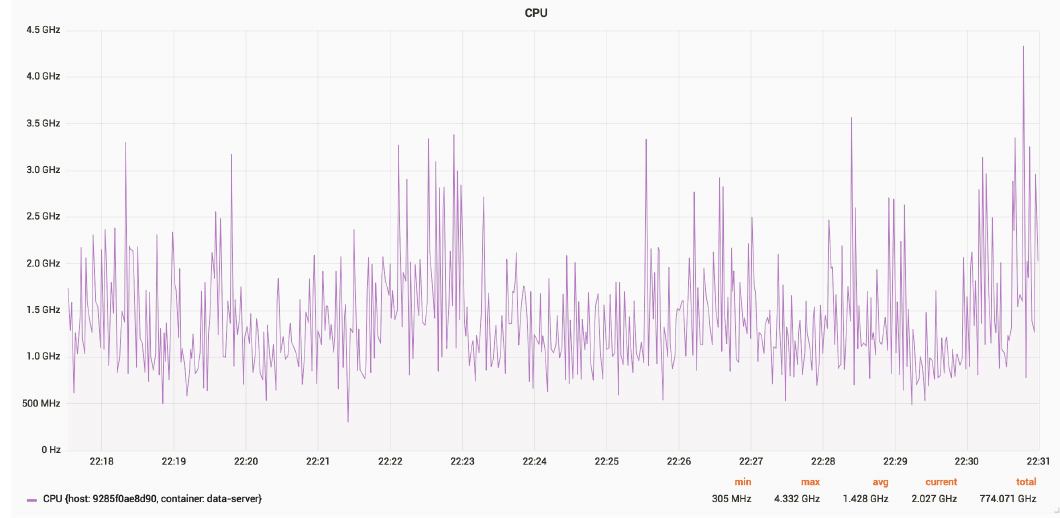
Figure 28. CPU usage for a server.